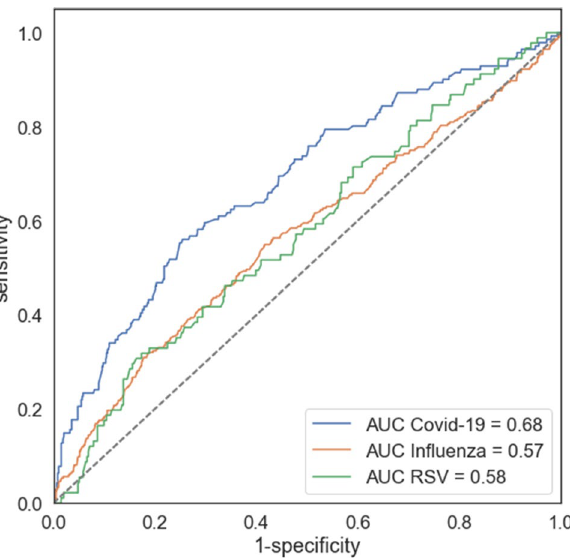
Figure 3. Receiver operating characteristic (ROC) curves analyses for predicting poor outcomes for COVID- 19, Influenza and RSV patients. NLR neutrophil-to-lymphocyte ratio, COVID-19 coronavirus disease 2019, RSV respiratory syncytial virus, AUC area under the curve.